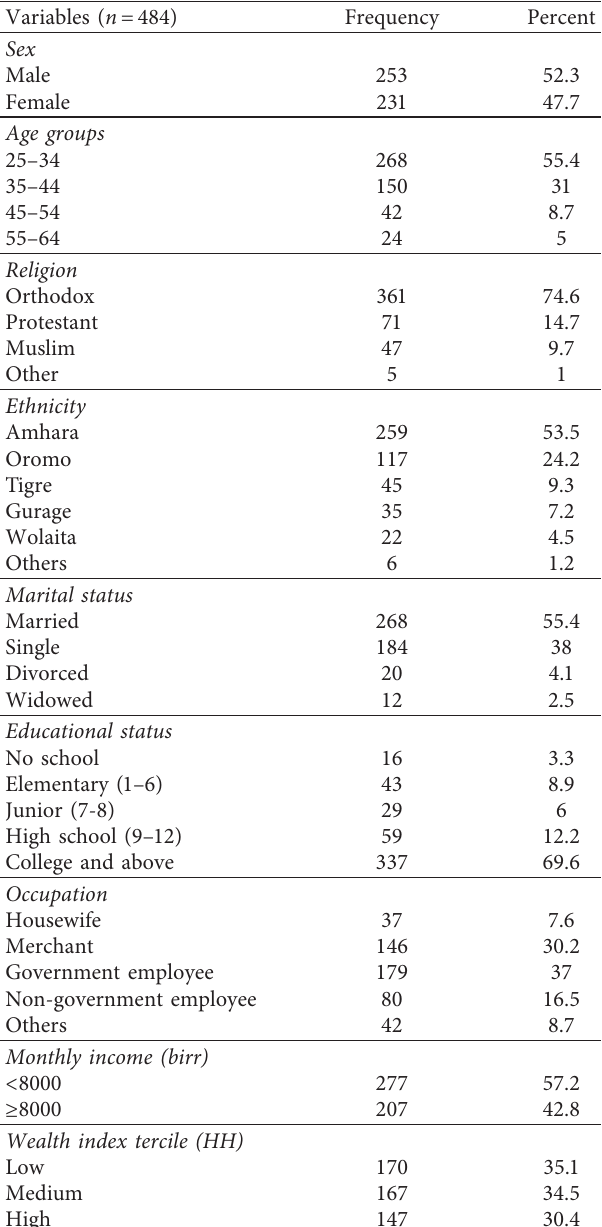
Table 1: The sociodemographic characteristics of the adult pop- ulation in Addis Ababa,